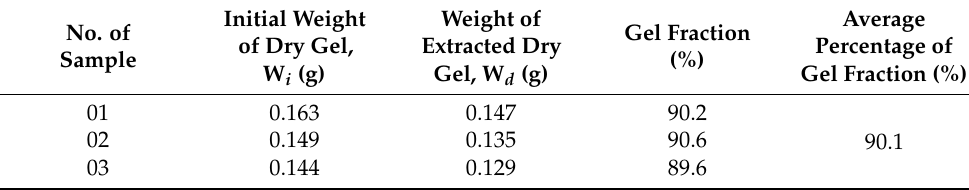
Table 1. Determination of gel fraction in